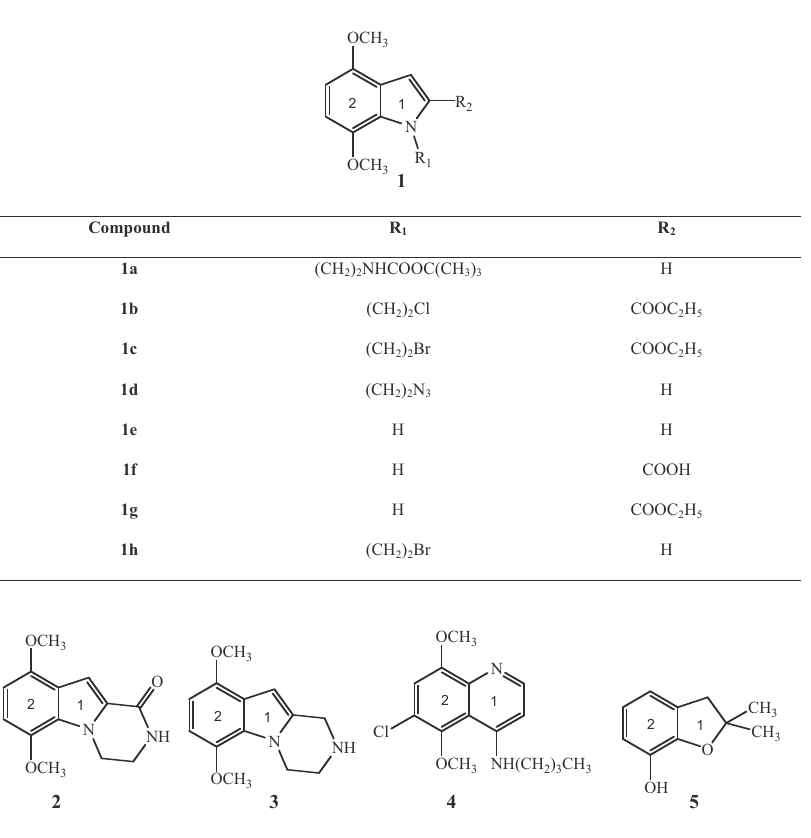
Fig. 1. – Structure of non-quinonic compounds